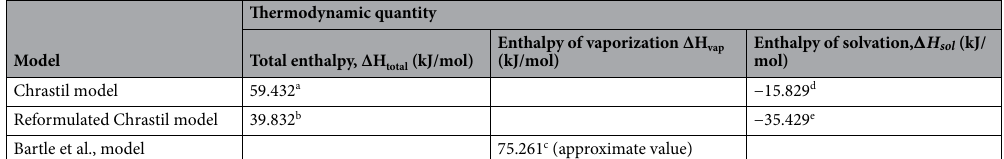
Table 6. Calculated thermodynamic properties of pantoprazole sodium sesquihydrate. d Magnitude difference